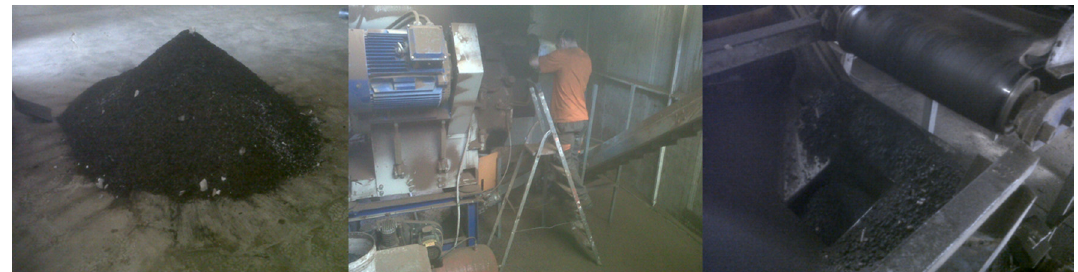
Figure 3. Sequence of events during the pelletization tests. Left: the pile already mixed and homogenized. Center: a view of the pelletizer used in the tests. Right: the product at the exit.